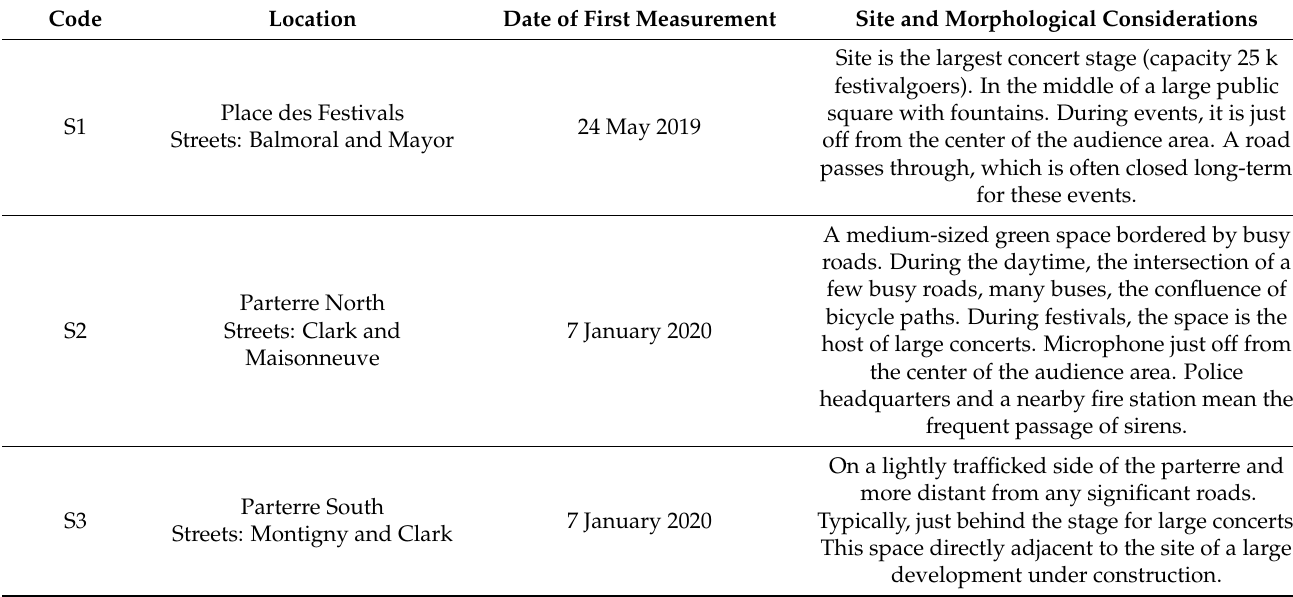
Table 2. Current measurement locations, earliest